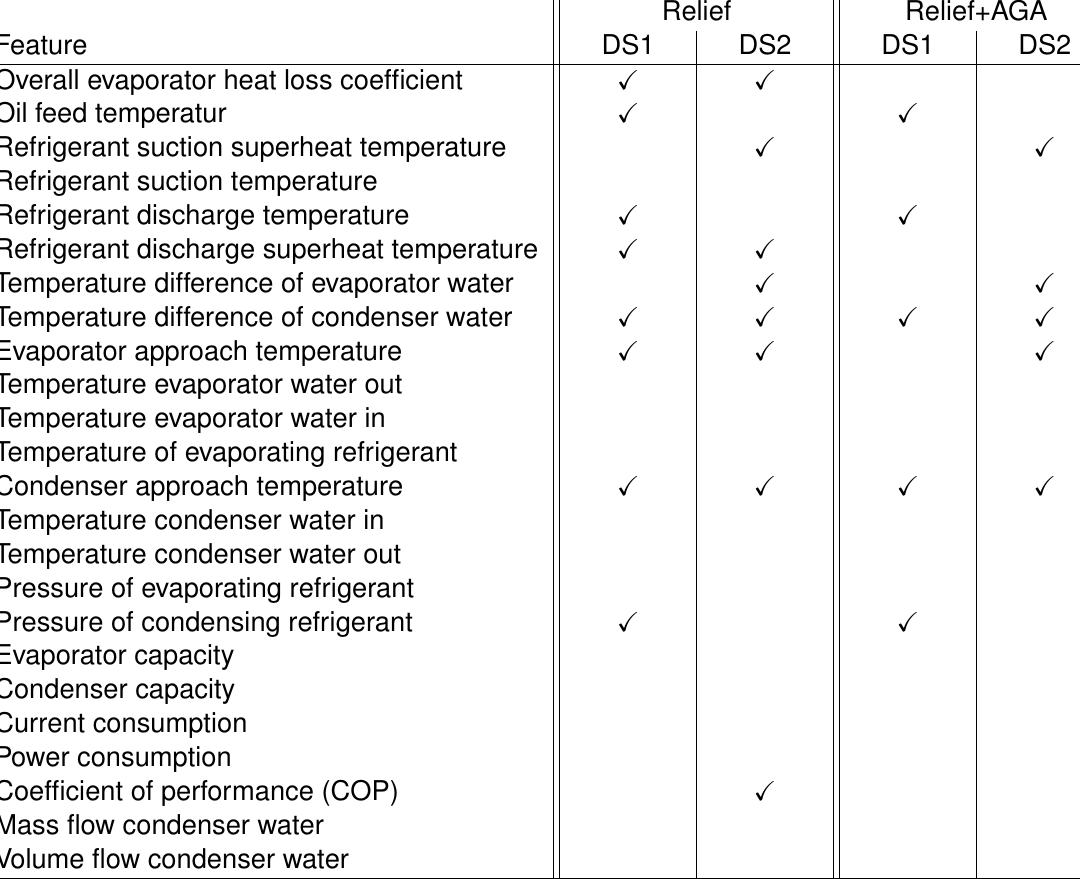
Table 3. Feature selection by Relief and Relief+AGA Relief Relief+AGA Feature DS1 DS2 DS1